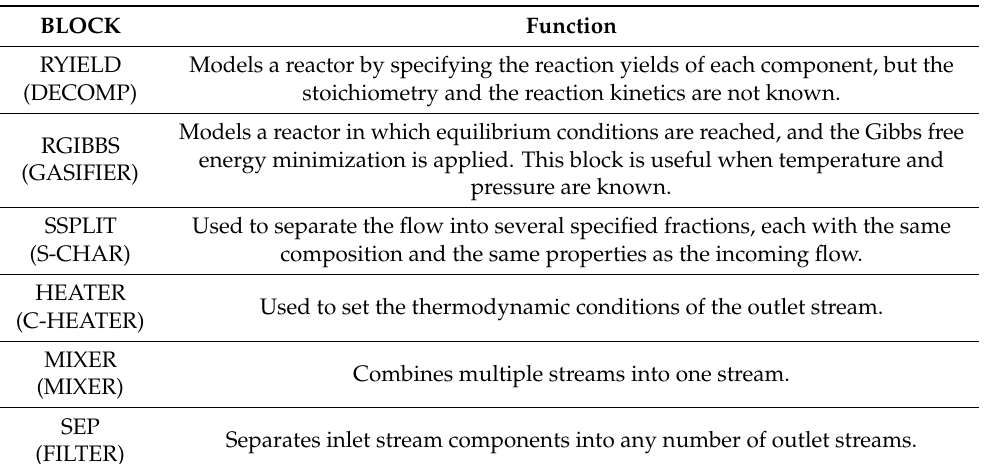
Table 1. Description of the blocks used in the model of gasification system in Aspen Plus referring to the nomenclature used in Figure